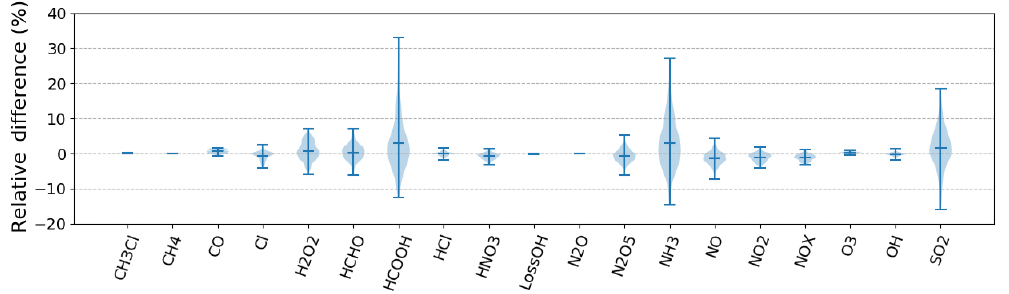
Figure 4. Aggregated mass difference between the accelerated and non-accelerated versions in the final month after 1 year of simulation time with the SCAV submodel